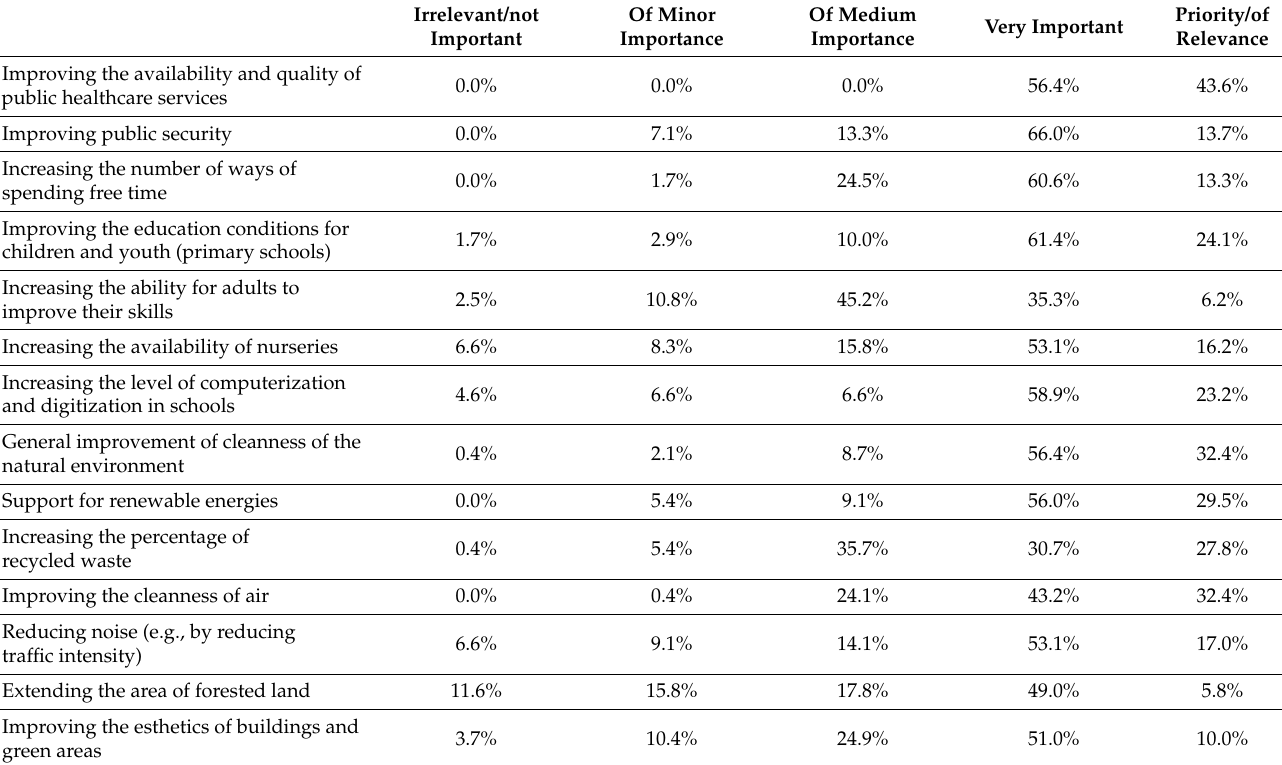
Table 6. Hierarchy of importance of measures taken to improve the standards of